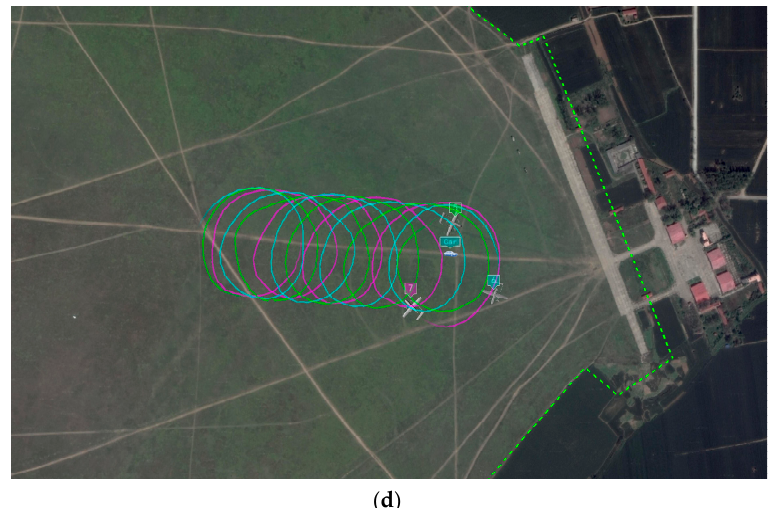
Figure 20. The snapshots of cooperative standoff tracking shown on the Ground Control Station in the HIL simulation. ( a ) Gather around the target; ( b ) Adjust phase difference; ( c ) Track the constant-speed target; ( d ) Track the accelerating target.